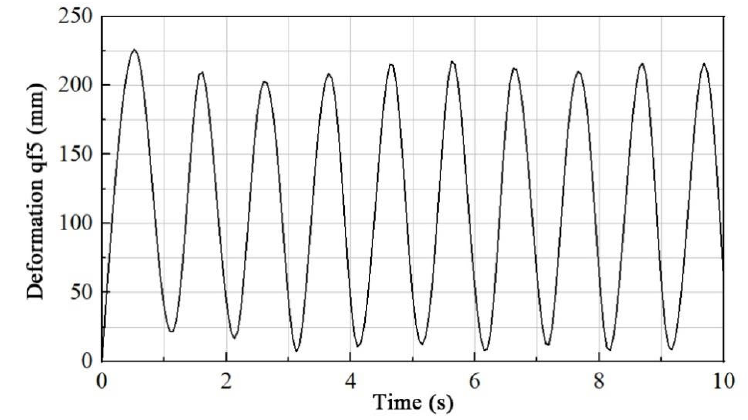
Figure 6. Lateral Deformation of the Top Node.